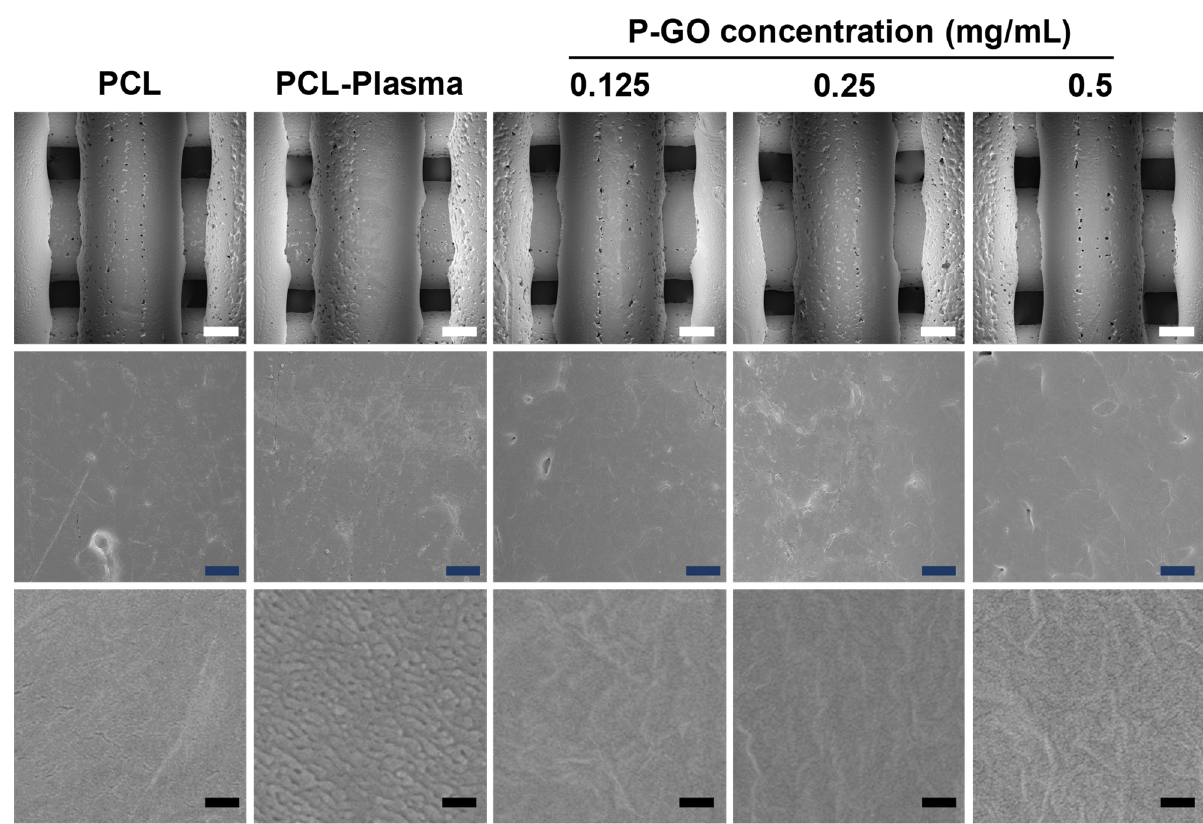
Figure 4. Field emission scanning electron microscopy (FE-SEM) images of scaffolds at 150×, 10,000×, 30,000× magnification. White scale bars; 200 μ m, navy scale bars; 10 μ m, purple scale bars; 0.25 μ m. (P-GO; Oxygen plasma-graphene oxide coating).